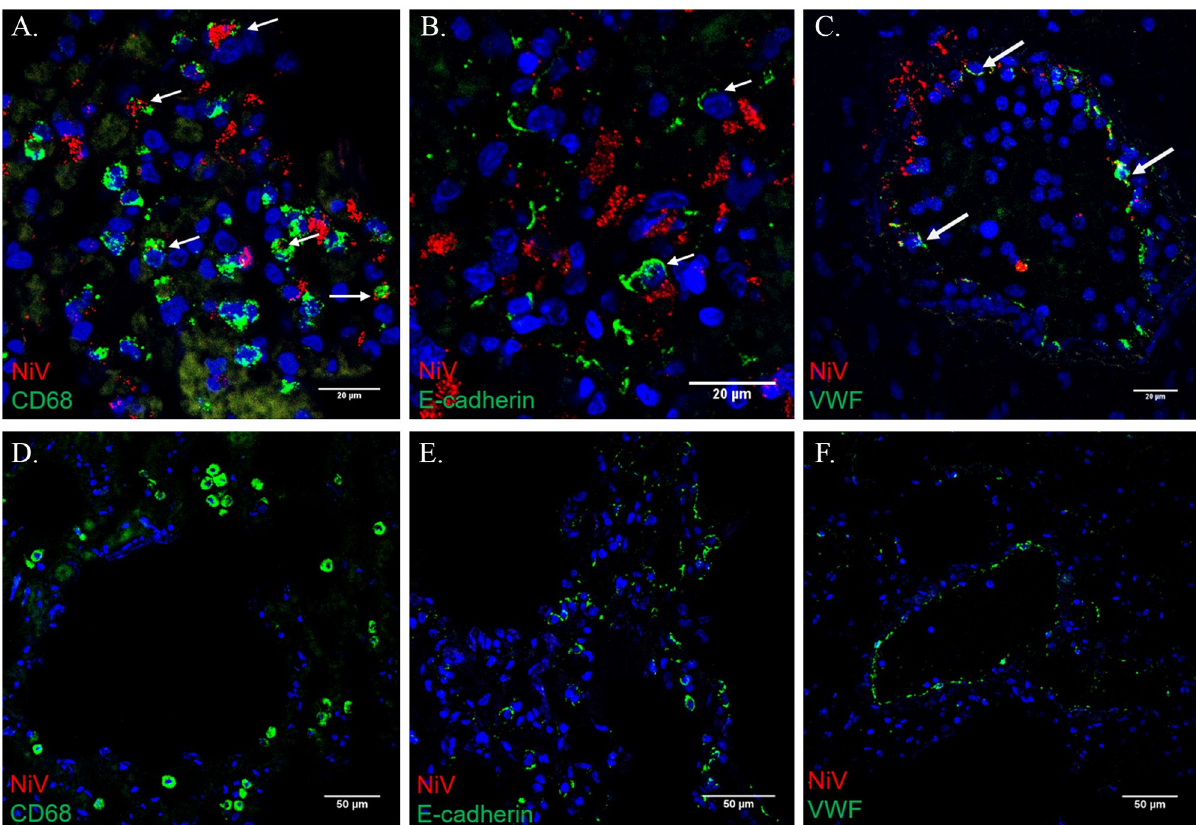
Fig 5. Lung—IFA. Image A, AGM 1: Immunofluorescence labeling demonstrates NiV antigen (red) detected in CD68+ macrophages (green), identified by white arrows. Image B, AGM 1: Immunofluorescence labeling demonstrates NiV antigen (red) is not detected in E-Cadherin + pneumocytes (green), identified by white arrows. Image C, AGM 1: Immunofluorescence labeling demonstrates NiV antigen (red) is detected in Von Willebrands factor+ endothelial cells (green), identified by white arrows. Image D, AGM 4: NiV antigen (red) was not detected in CD68+ macrophages (green). Image E, AGM 4: NiV antigen (red) was not detected in E-cadherin+ pneumocytes (green). Image F, AGM 4: NiV antigen (red) was not detected in VWF+ endothelial cells (green).